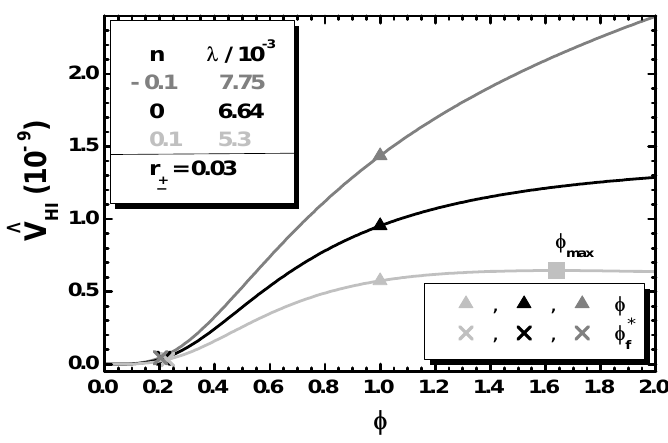
Figure 1. The inflationary potential λ = 7.75 10 − 3 (gray line), n = 0, λ = 6.64 ×